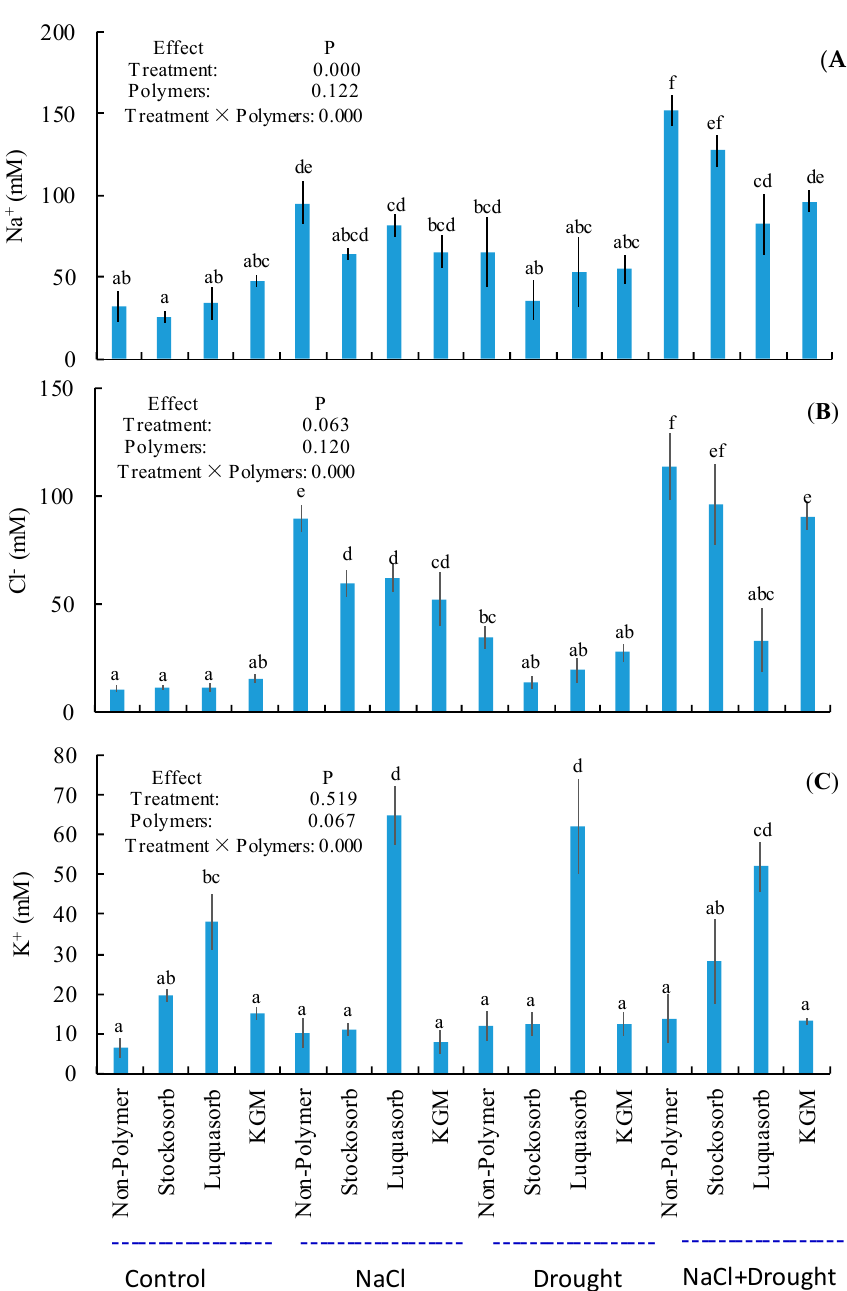
Figure 8. Effects of drought and salt stress on Na + , Cl − , and K + concentrations in soils supplemented without synthetic (Stockosorb, Luquasorb) and natural (Konjac glucomannan, KGM) hydrophilic polymers along with soils not supplemented with polymers (Non-Polymer). ( A ): Na + concentration. ( B ): Cl − concentration. ( C ): K + concentration. Each column represents the mean of three to five soil samples and bars represent the standard error of the mean. Columns labeled with different letters (a–f) are significantly different at the p < 0.05